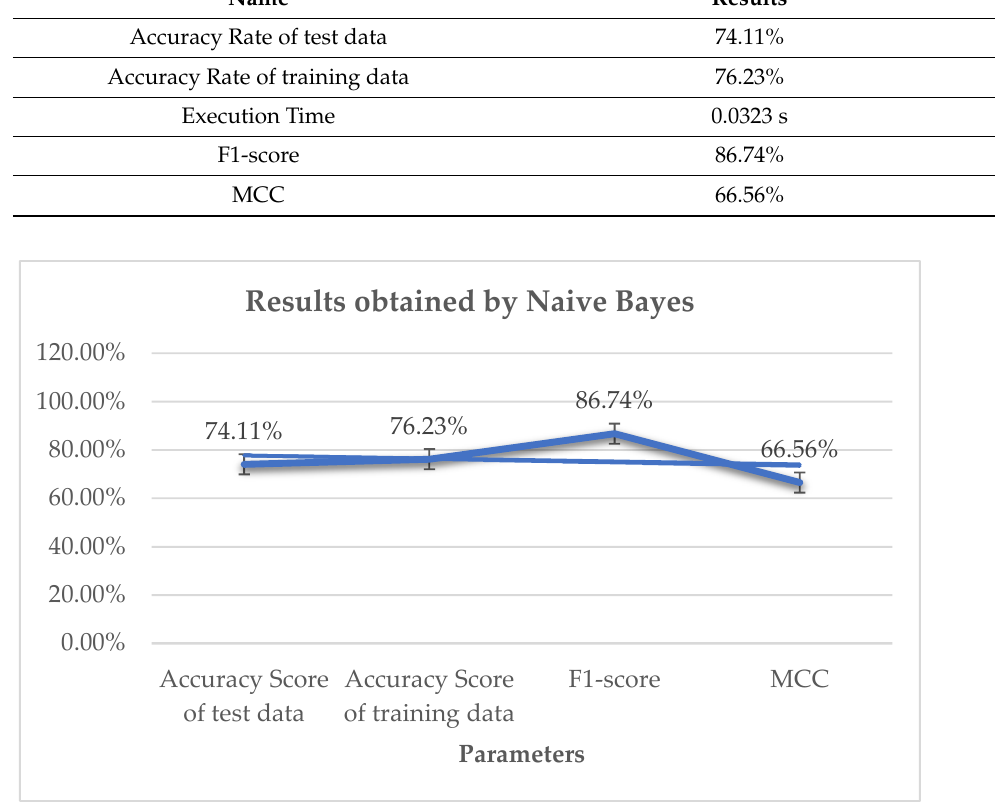
Figure 7. Results obtained by Naïve Bayes.